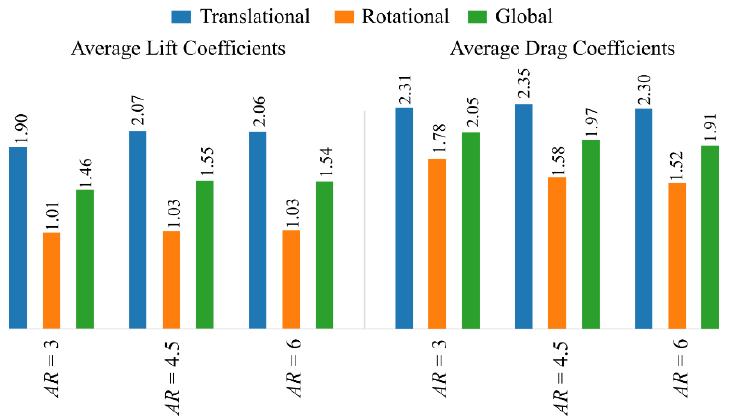
Figure 6. Average lift and drag coefficients for the translational phase, rotational phase, and whole/global wing stroke, for the different aspect ratios. whole/global wing stroke, for the different aspect